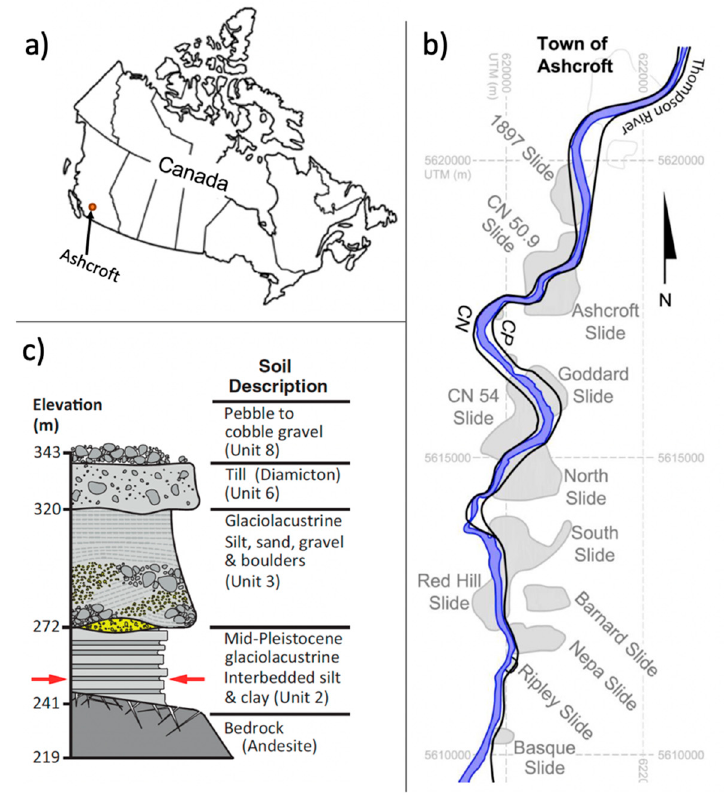
Figure 8. Location of landslides south of Ashcroft ( a ), detailed landslide layout ( b ), and stratigraphy in the area ( c ). Adapted from [42].